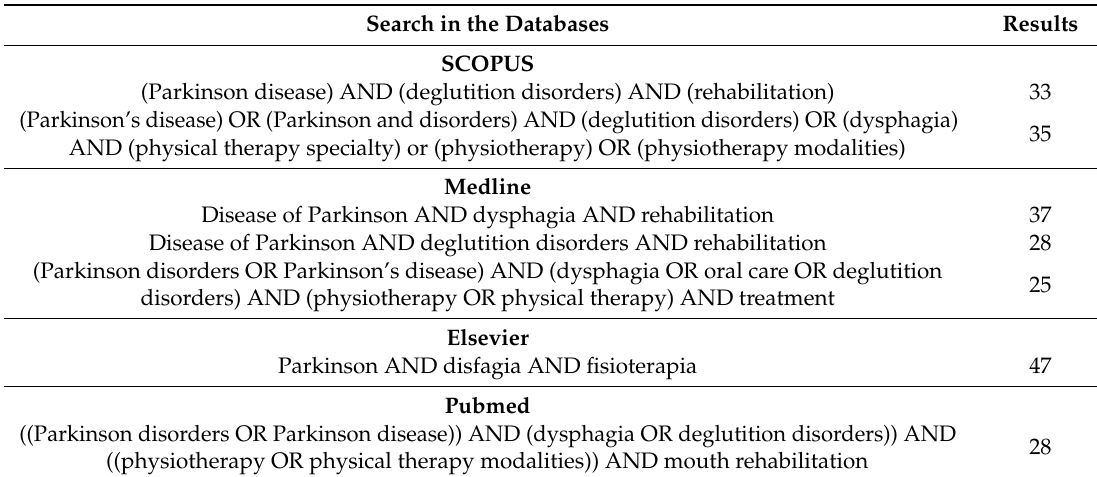
Table 1. Systematic syntax in the